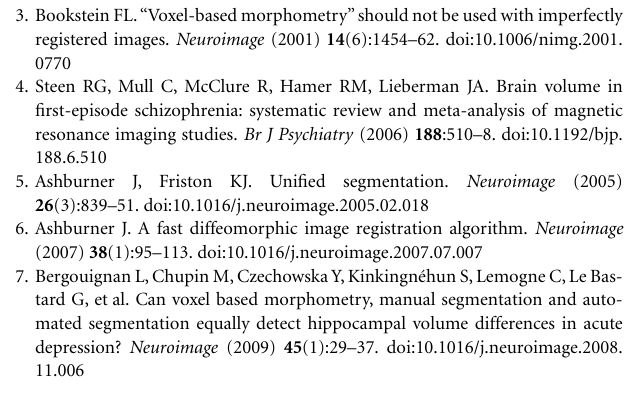
FIGURE 3 | Superimposed SPM results .Thresholded SPM results (uncorrected p < 0.0001) superimposed on the averagedT1-weighted images of all subjects are shown.The color scale represents SPM t-scores, images